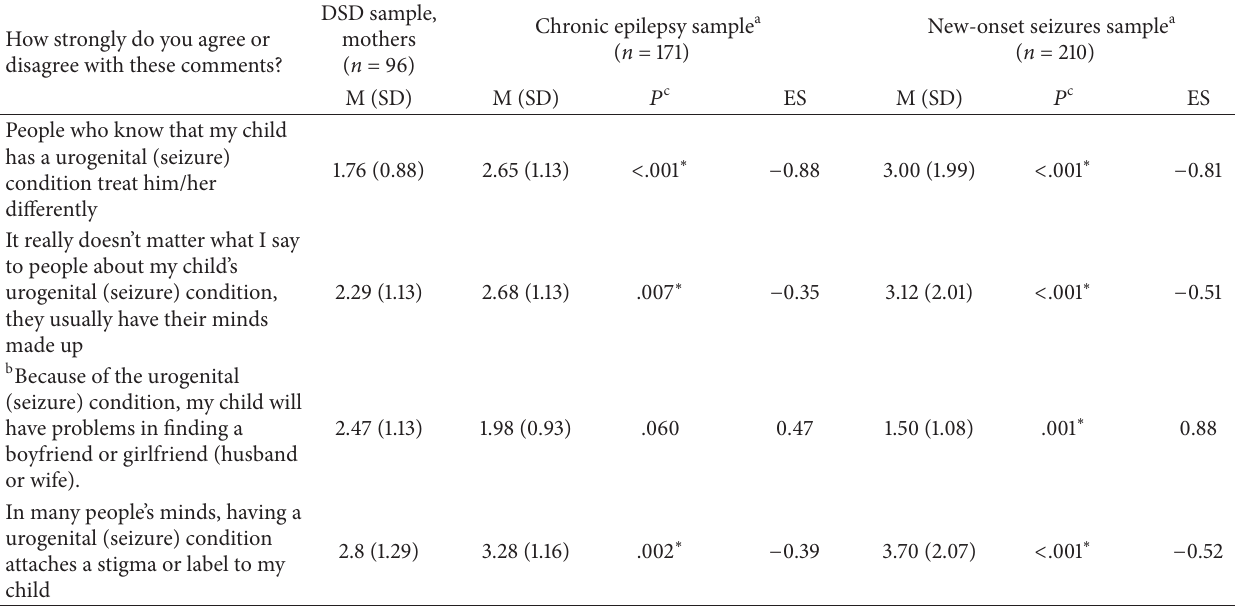
Table 7: Reported stigma in DSD compared to parents of children with